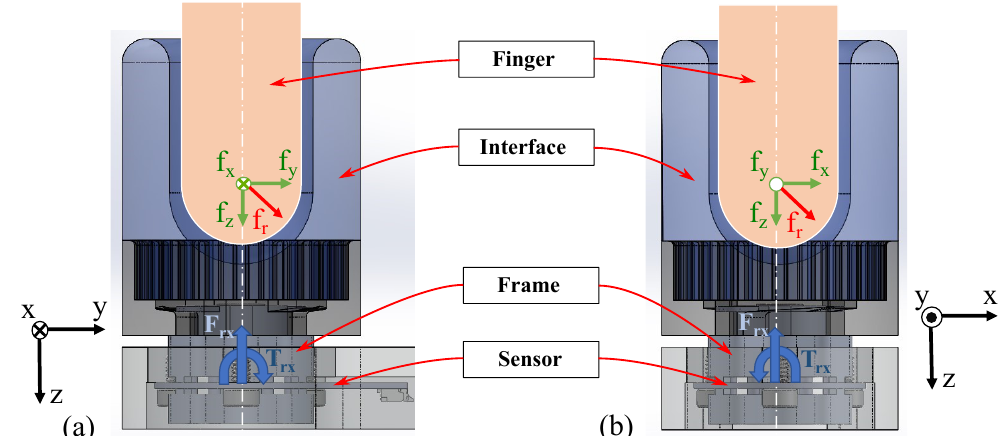
Figure 12. Free-body diagram of the human finger and the 3-DOF sensor within the overall assembly, viewed from the side ( a ) and front ( b ). Total force exerted by the finger onto the assembly is broken down into axial components, designated by green arrows. The resultant finger force is represented by a red arrow. The axial directions are indicated by black coordinate frames to the side. Reaction force and torque are also indicated at the sensor by blue arrows. The reaction components contribute to bending of the sensor, which are sensed by the gauges.